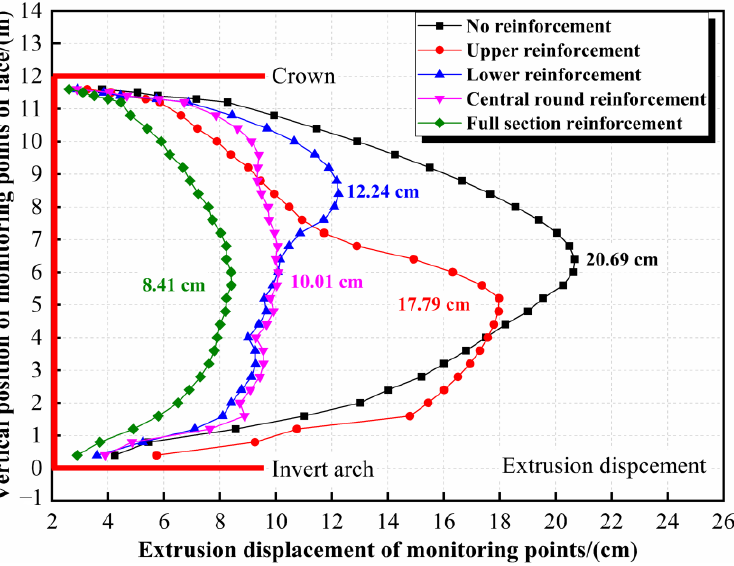
Figure 18. Extrusion displacement of target face under different reinforcement